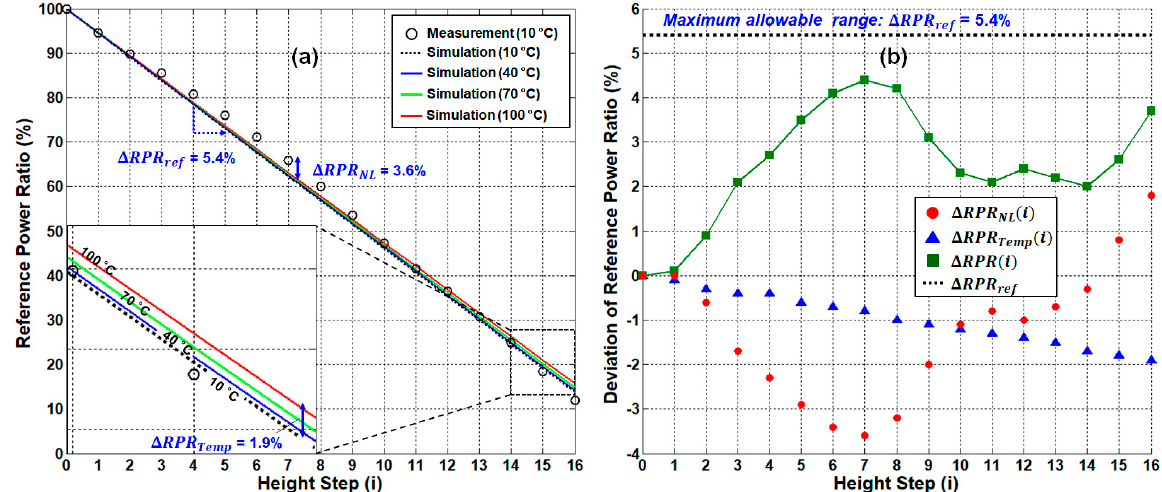
Figure 5. ( a ) Reference-to-power ratio ( 𝑅𝑃𝑅 ) according to the water level in the back-to-back condition and ( b ) the 𝑅𝑃𝑅 deviation according to the system performance degradation factors. The inset of Figure 5a shows the enlargement part of the 𝑅𝑃𝑅 at the highest water level.